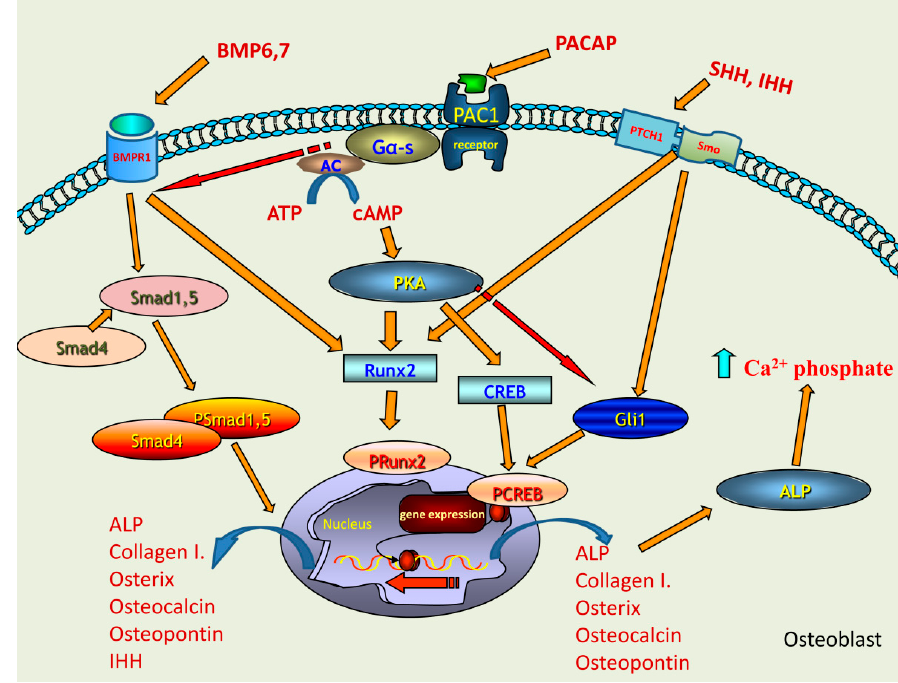
Figure 6. Schematic drawing of the possible signalling pathways regulated by PACAP in bone formation. PAC1 receptor activation leads to the increase of intracellular cAMP, which activates PKA. Downstream targets of PKA can be CREB or Runx2 transcription factors which activations induce the expression of collagen type I, osterix, osteocalcin, ostepontin and ALP. BMP6 and BMP7 binding to BMPR1 triggers the activation of Smad cascade which can induce the expression of collagen type I, osterix, osteocalcin, ostepontin, ALP and IHH. The activation of BMP signalling is fine-tuned by the activation of PACAP signalling. Runx2 phosphorylation can occur via BMPR1 activation, showing a PACAP independent mechanism. IHH and SHH activate Gli1 transcription factor which is